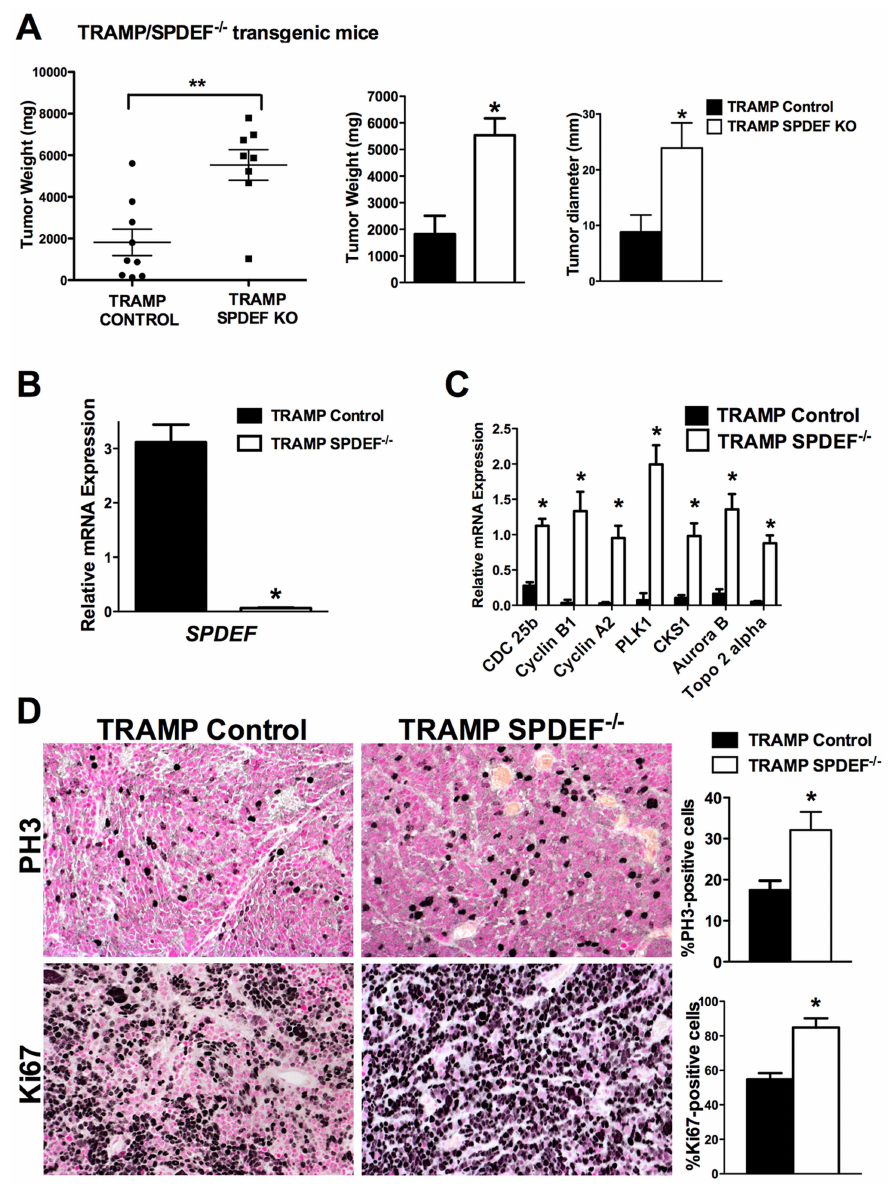
Figure 1. Prostate carcinogenesis is increased in SPDEF 2 / 2 mice. Experimental TRAMP/SPDEF 2 / 2 and control TRAMP mice were sacrificed at 23 weeks of age. A . Deletion of SPDEF increased the weight and sizes of prostate glands. Mean weights and diameters of prostate glands ( 6 SD) were calculated from 8–9 mouse prostates per group. B . Efficiency of SPDEF deletion is shown by qRT-PCR. Total prostate RNA was prepared from TRAMP/ SPDEF 2 / 2 and TRAMP mice. b -actin mRNA was used for normalization. Data represent means 6 SD of three independent determinations using prostate tissue from n=5–10 mice in each group. C . Increased mRNA levels of Cdc25b , Cyclin B1, Cyclin A2 , Plk-1, CKS1, Aurora B and Topo2-alpha were found in TRAMP/SPDEF 2 / 2 prostates by qRT-PCR. Data represent means 6 SD of three independent determinations (n=5–10 mice in each group). D . Increased cellular proliferation in TRAMP/SPDEF 2 / 2 prostates. Mouse prostate glands were harvested 23 weeks after birth and used for immunohistochemistry with Ki-67 and PH3 antibodies. Number of positive cells were counted in 5 random microscope fields (n=6 mice per group). Data represent mean 6 SD. A p value , 0.01 is shown with (**) and p value , 0.05 is shown with (*). Magnification: panels D, 200 6 . expression of SPDEF in prostate epithelial cells through excision of the LoxP-stop-LoxP cassette by the Probasin-driven Cre recombi- nase (Figure 4A). SPDEF OE mice were healthy and fertile, their prostates were normal. To induce prostate cancer, the SPDEF OE mice were bred with TRAMP transgenic mice to generate